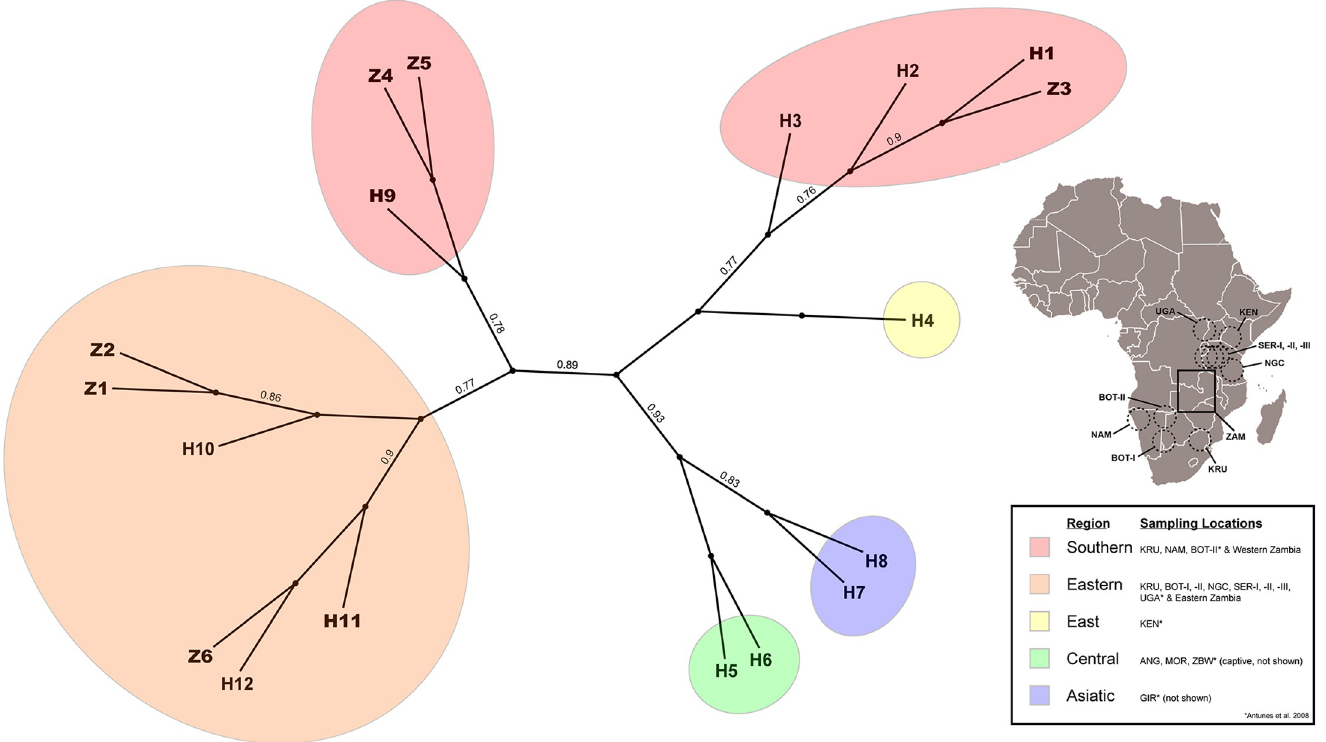
Fig 2. Radiated maximum likelihood tree with branch support. Clades are colored by region. Haplotypes in bold are found in Zambia. Map insert is from Curry et al. 2015 showing locations of lions sampled. Circles indicate geographic locations for populations determined by Antunes et al [15]. UGA (Uganda); KEN (Kenya); SER (Serengeti National Park, Tanzania); NGC (Ngorongoro Crater, Tanzania); KRU (Kruger National Park, South Africa); BOT-I (Southern Botswana and Kalahari, South Africa); BOT-II (Northern Botswana); NAM (Namibia); GIR (Gir Forest, India); ANG (Angola); ZBW (Zimbabwe); and MOR (Morocco). ZAM (Zambia) is denoted by a